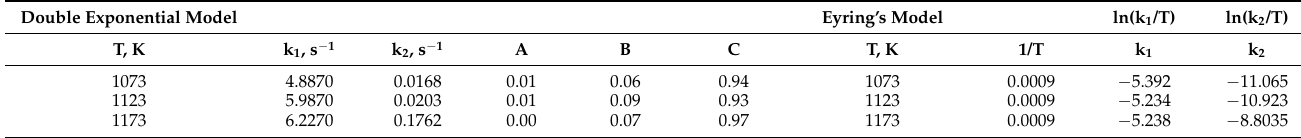
Table 6. Kinetic parameters obtained applying the DE